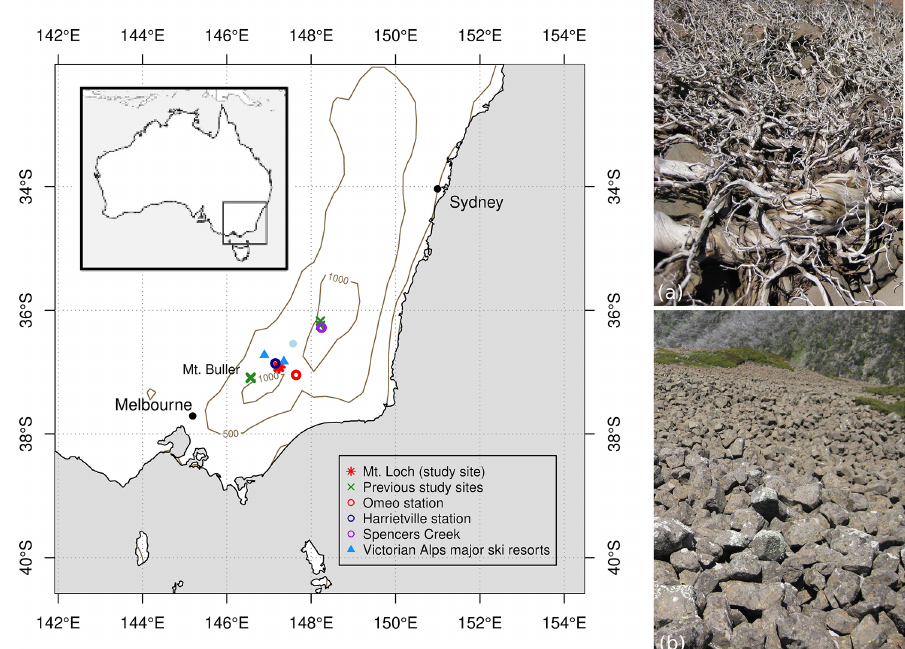
Figure 1. Left: location of Mt Loch sample site and main meteorological stations and P. lawrencei study sites from previous works (Mt Blue Cow and Schlinks Pass: McDougall et al., 2012; Mt Buller: Brookhouse and Graham, 2016). Right: (a) Highly prostrate growth of fire-killed P. lawrencei stands from the same locality. (b) Mt Loch boulder field on rock-scree slope, from which samples for this study were collected. Images taken by Matthew Brookhouse (the Australian National University (ANU)).